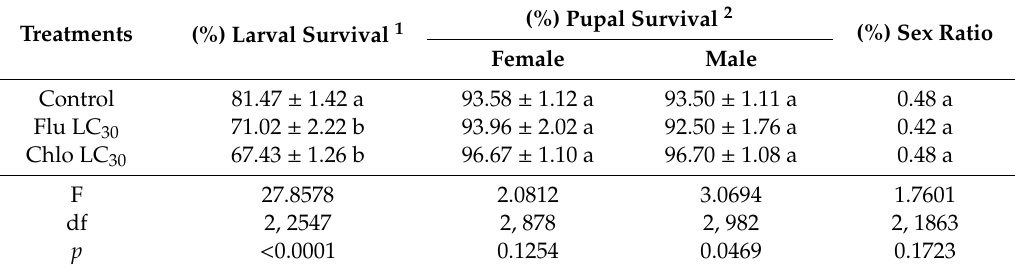
Table 3. Sublethal e ff ects of flubendiamide (Flu) and chlorantraniliprole (Chlo) on larvae and pupal survival and the sex ratio of resulting adult Chloridea virescens under controlled laboratory